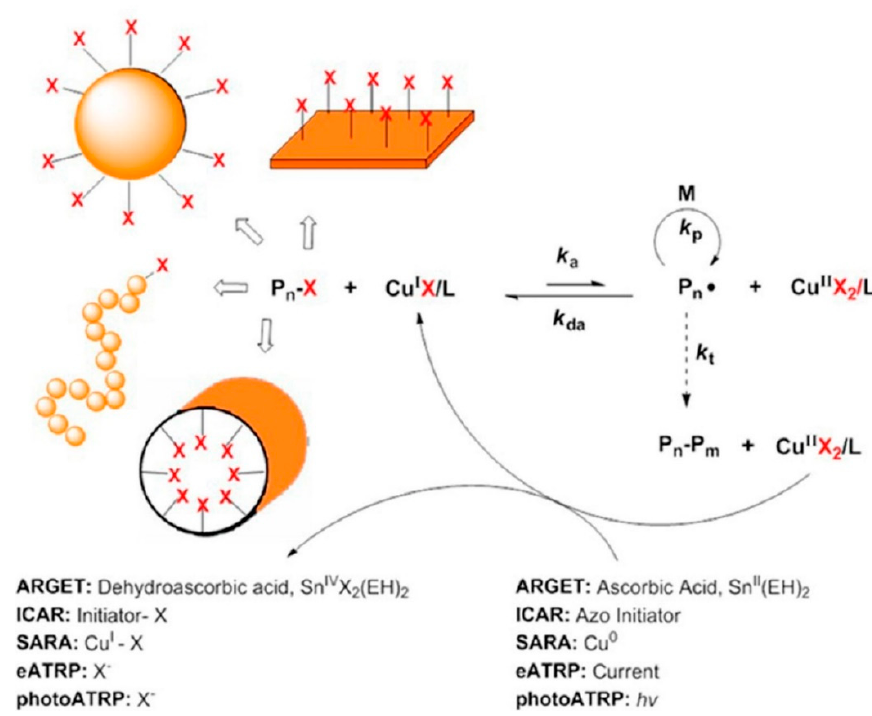
Scheme 1. Schematic illustration for ATRP and surface-initiated atom transfer radical polymerization (SI-ATRP) technique. Reproduced with permission from reference [29].